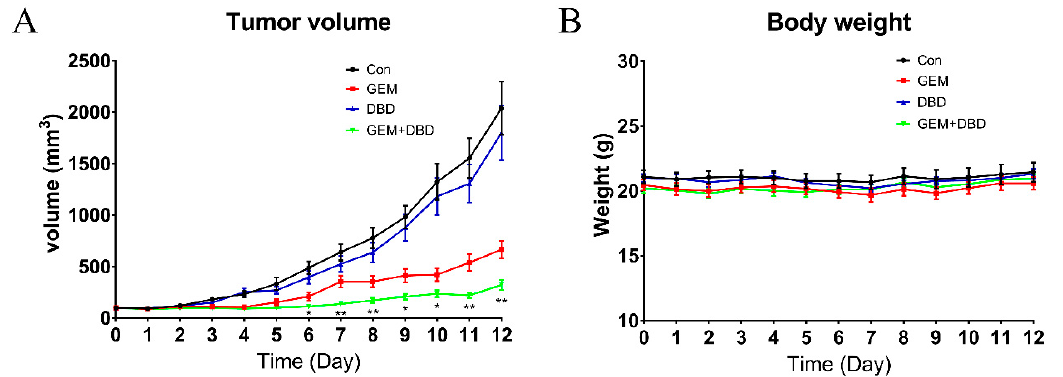
Figure 1. Tumor volume ( A ) and body weight ( B ) of Lewis lung carcinoma (LLC) tumor-bearing mice during 12 days of treatment. Data were expressed as mean ± SEM ( n = 10). * p < 0.05, Gemcitabine (GEM) + Danggui Buxue decoction (DBD) versus GEM. ** p < 0.01, GEM + DBD versus GEM. Mice were administrated vehicle alone (saline), GEM alone (100 mg/kg i.p., once a week), DBD alone (1.8 g/kg i.g., each day), or a combination of GEM and DBD (same as the relevant single drug group).